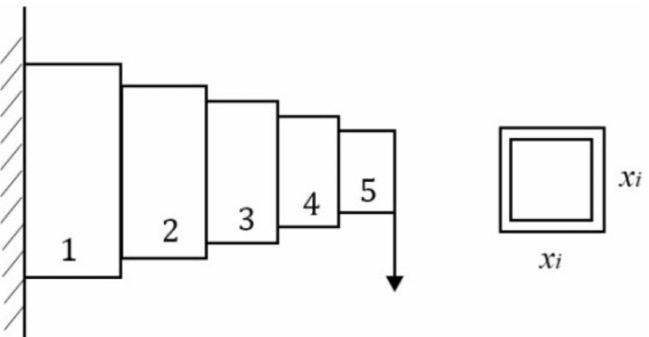
Figure 10. Cantilever beam design.